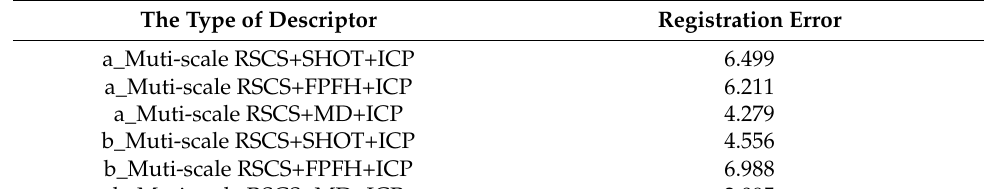
Figure 16. Results of different registration schemes for part 2: ( a ) coarse registration; ( b ) fine regis- tration.